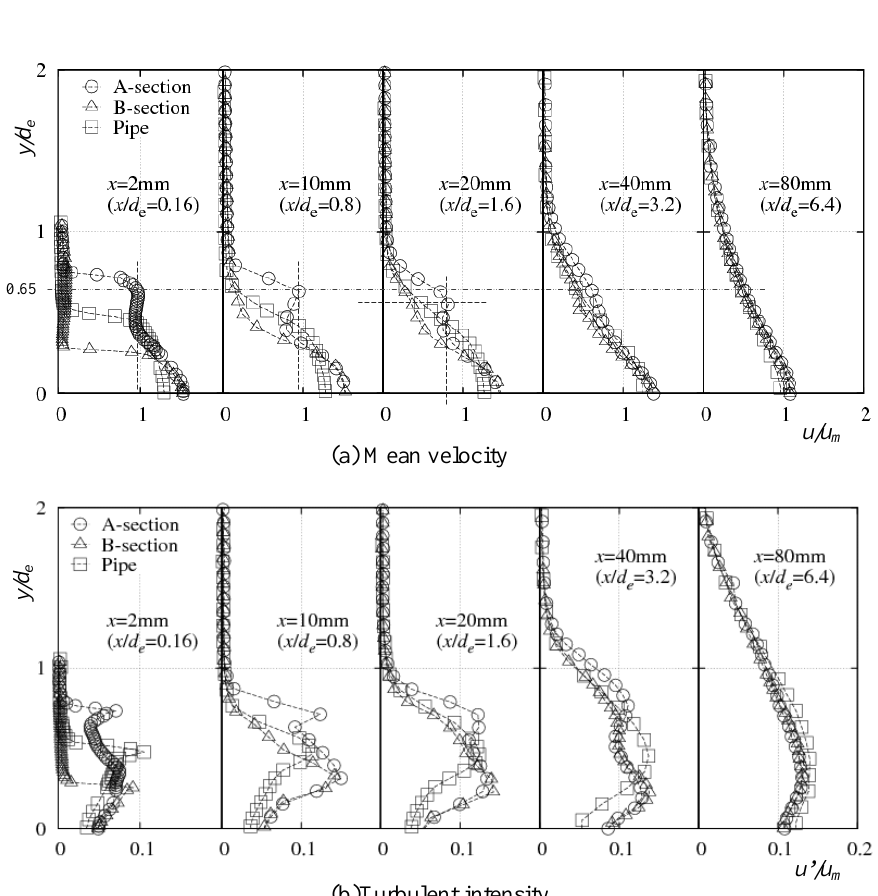
Fig.10 Mean and fluctuating velocities